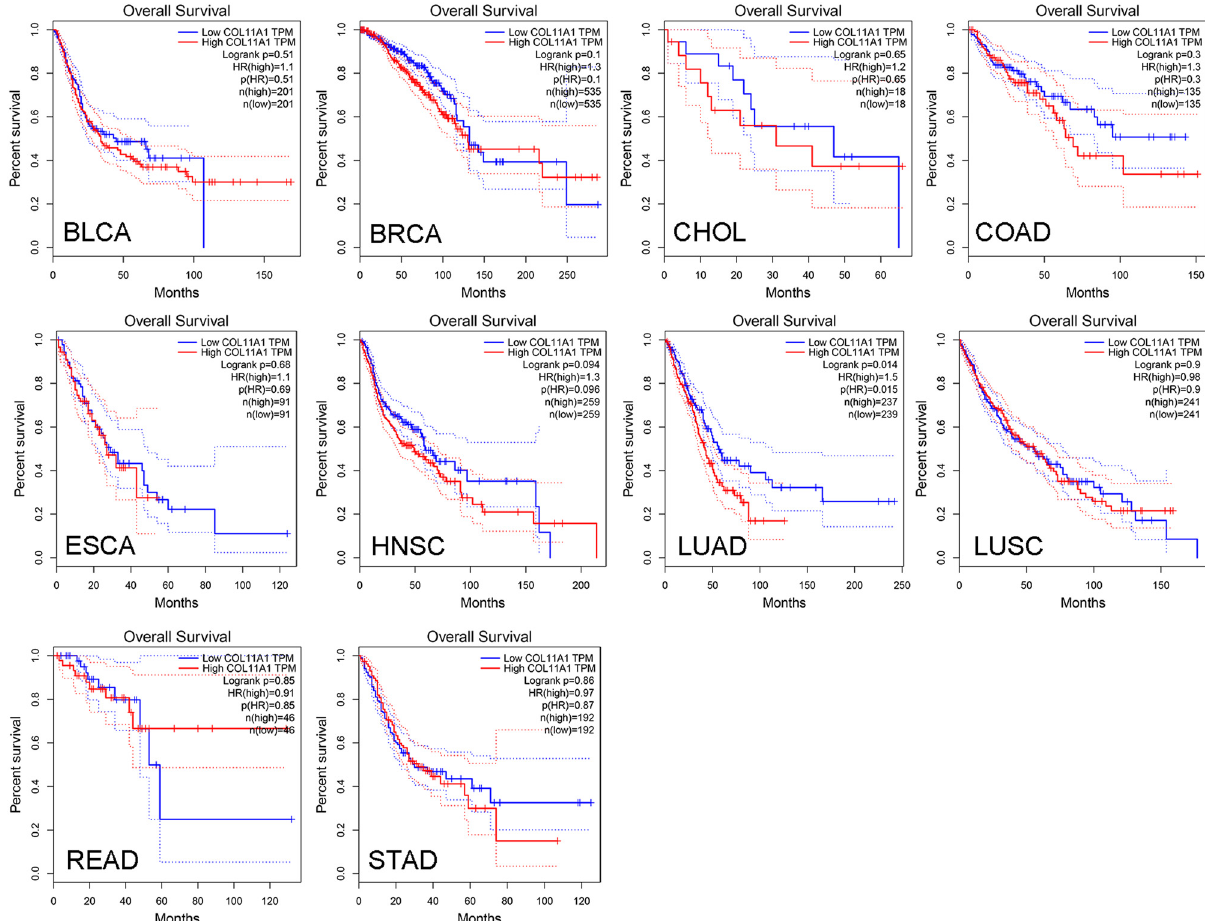
Figure 2: COL11A1 correlates with overall survival ( OS ) in LUAD. The association between COL11A1 and OS in 10 cancer types was determined by the GEPIA